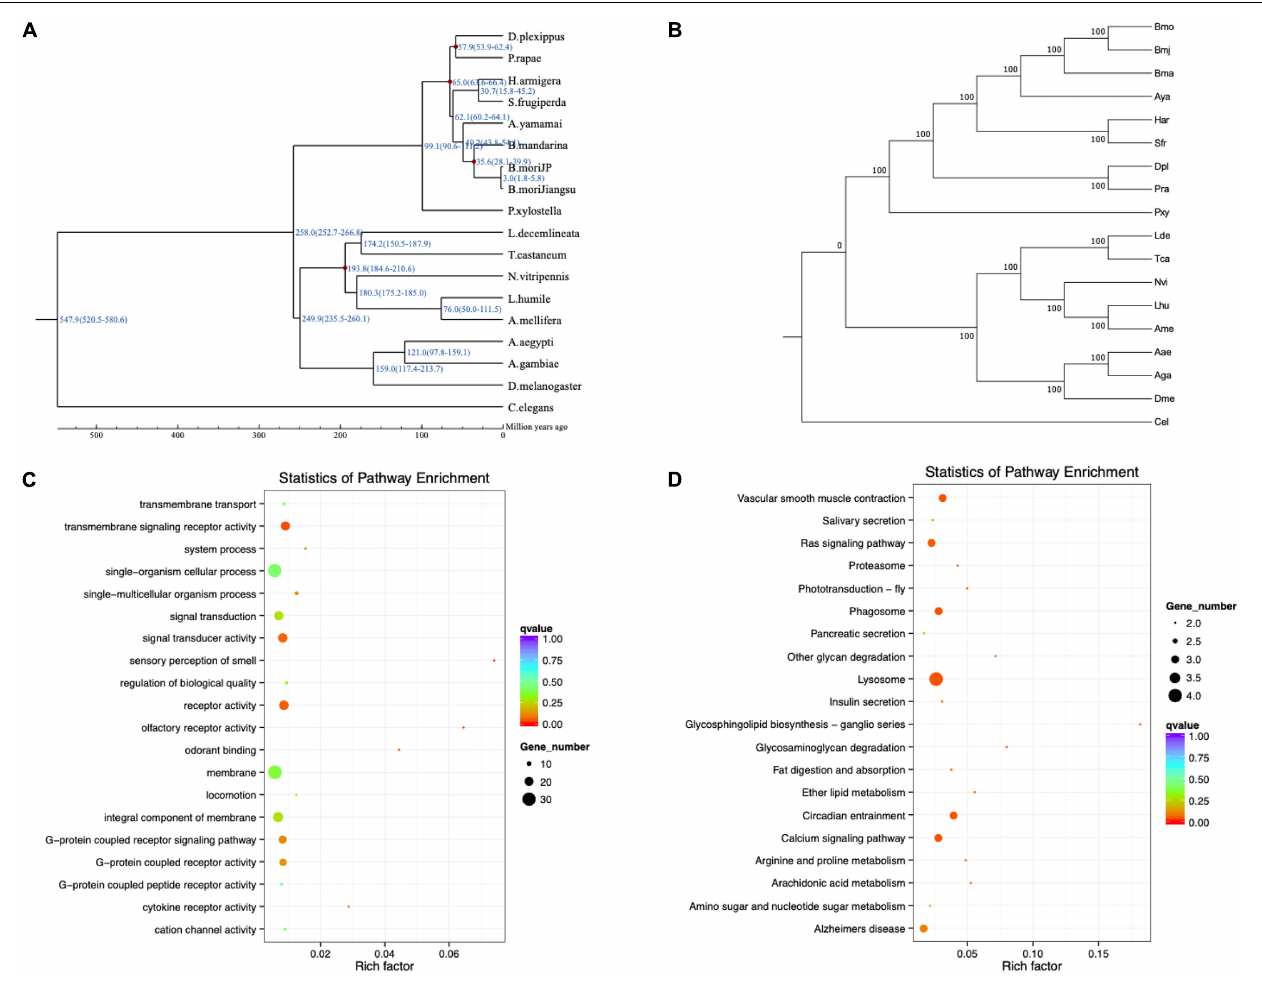
FIGURE 4 | Evolutionary analysis of B. mori by Gene Ontology (GO) and Kyoto Encyclopedia of Genes and Genomes (KEGG) pathway enrichment analysis. (A) Divergence time estimation of B. mori and closely related species. The divergence time is shown at the branches of the phylogenetic tree, along with the confidence intervals in parentheses. (B) Phylogenetic tree of Bmj species. (C,D) GO and KEGG pathway enrichment analysis of positively selected genes related to BmNPV